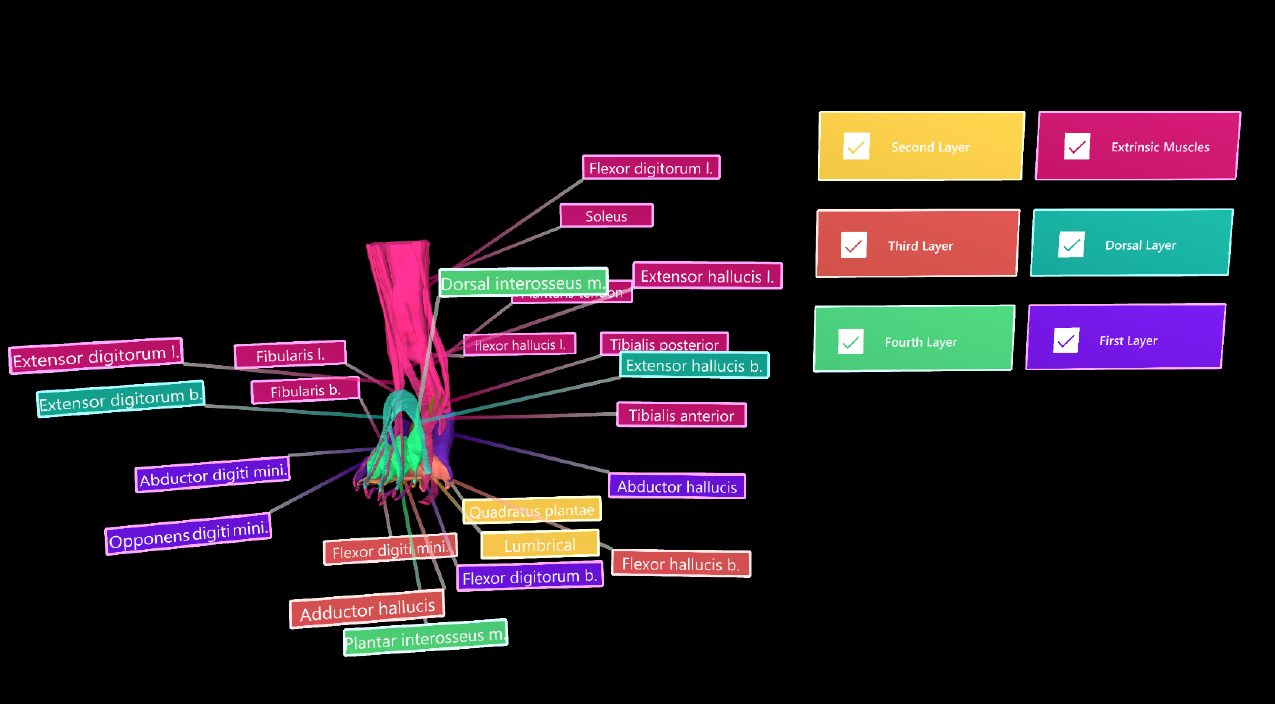
Figure 10. Muscle objects imported into Unity 3D for demonstration of different groups/layers. Toggle switches and colour-coded extrinsic muscle group (magenta), dorsal layer (light blue), and first, second, third, and fourth plantar muscle layers.